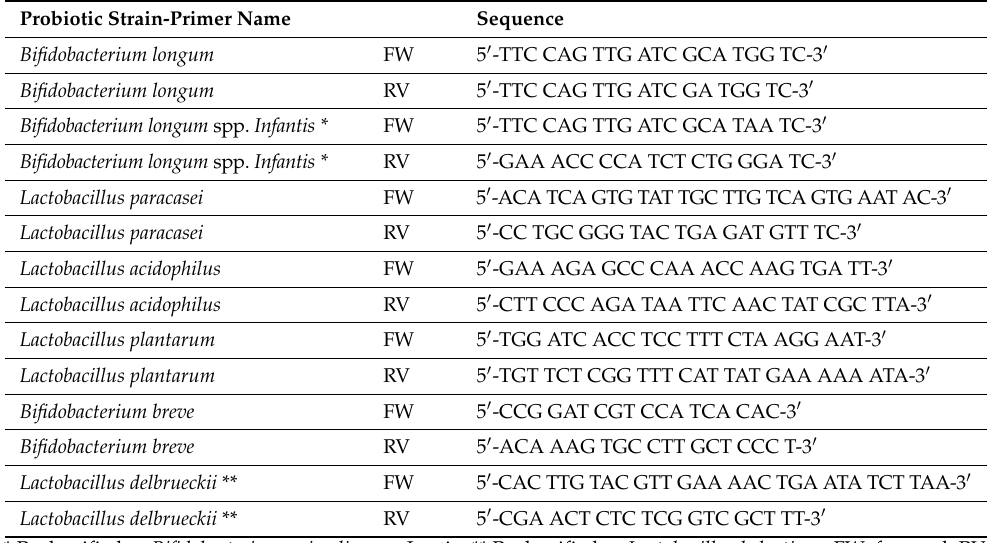
Table 1. Primer sequences used in the RT-qPCR assay for the detection of probiotic strains in food supplement 1.